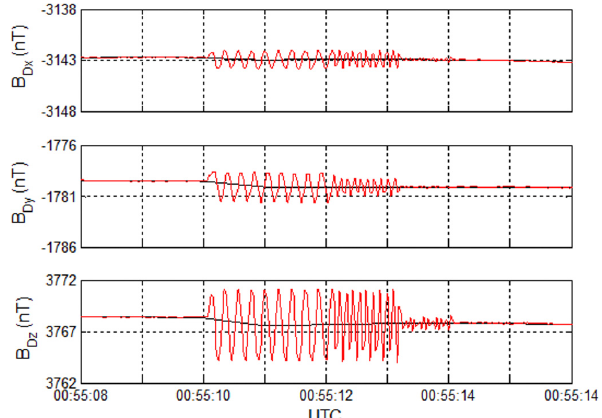
Fig. 9. Comparison of a Reaction Wheel event measured at 1Hz (black) and 32Hz (red) in the differenced MAG